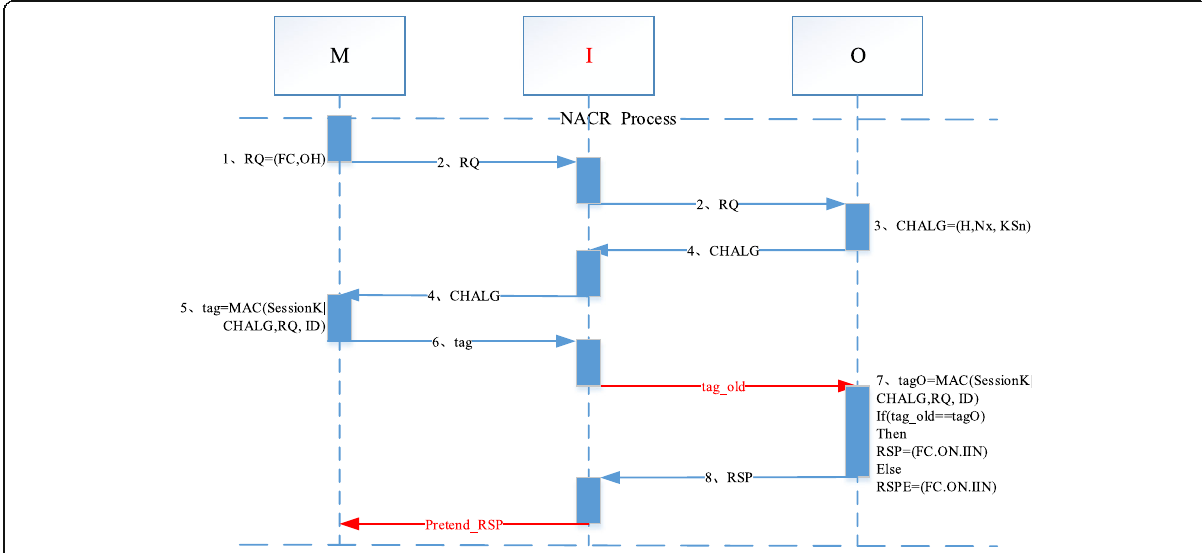
Fig. 3 The MSC model of second loophole